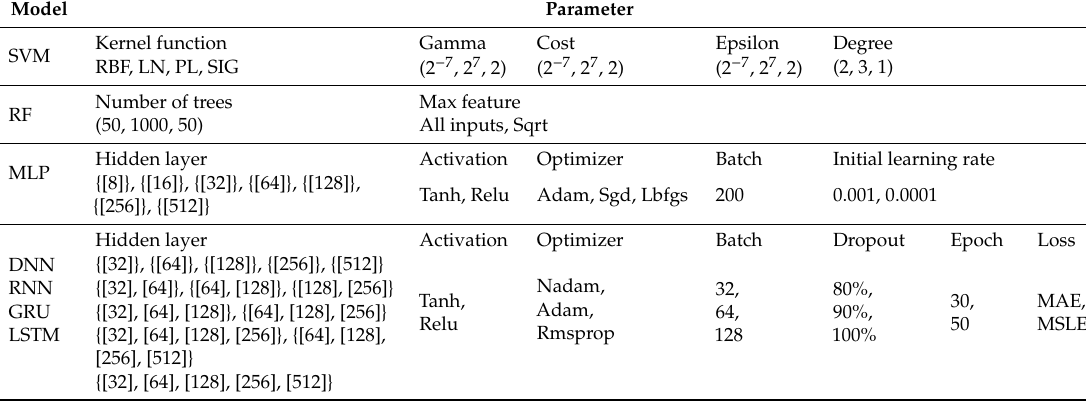
Table 4. The Candidate parameters of the